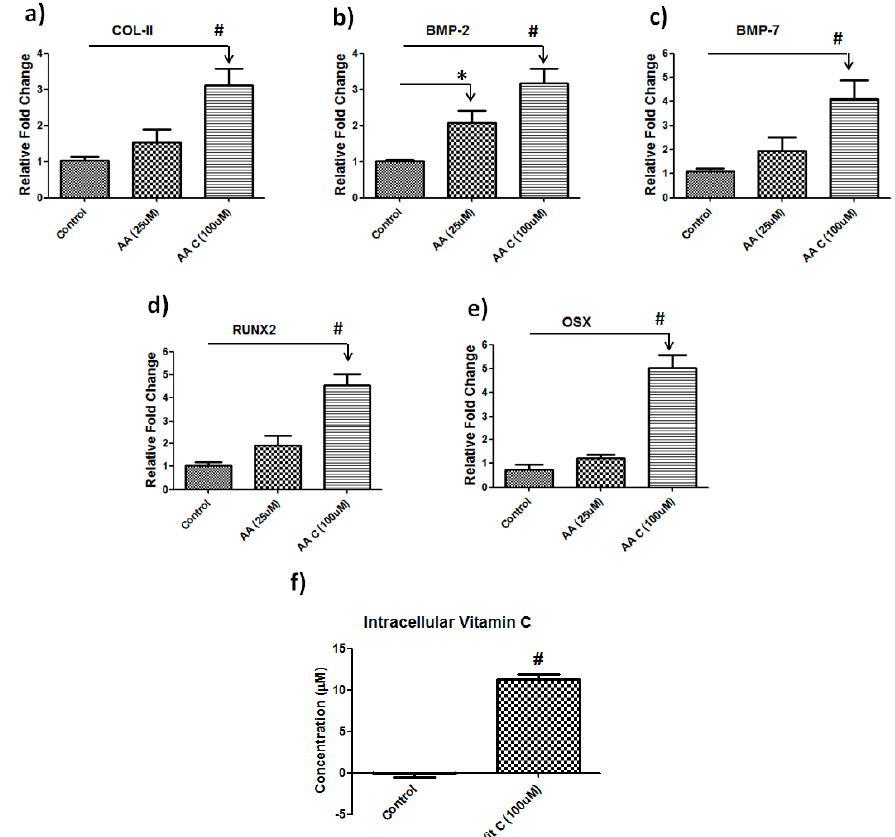
Figure 2. Vitamin C regulates musculoskeletal genes in hBMSCs. Real-time PCR showing dose dependent change in gene expression in hBMSCS after vitamin C treatment ( a ) Collagen II; ( b ) BMP-2; ( c ) BMP-7; ( d ) RUNX2 and ( e ) OSX (Osterix). Data ( n = 4) are represented as the fold change in expression compared with control (* p = 0.04, # p = 0.001); ( f ) Intracellular concentration of vitamin C